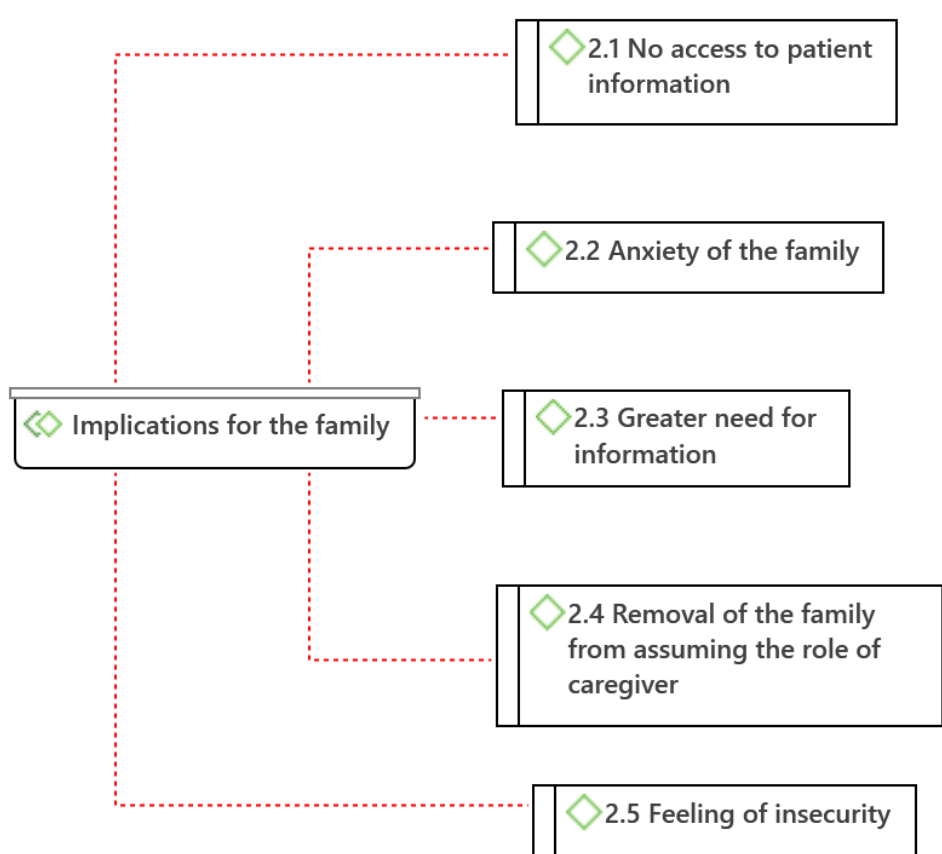
Figure 3. Categories of implications for the family by hospital visit restriction measures. (Atlas.ti ® ).